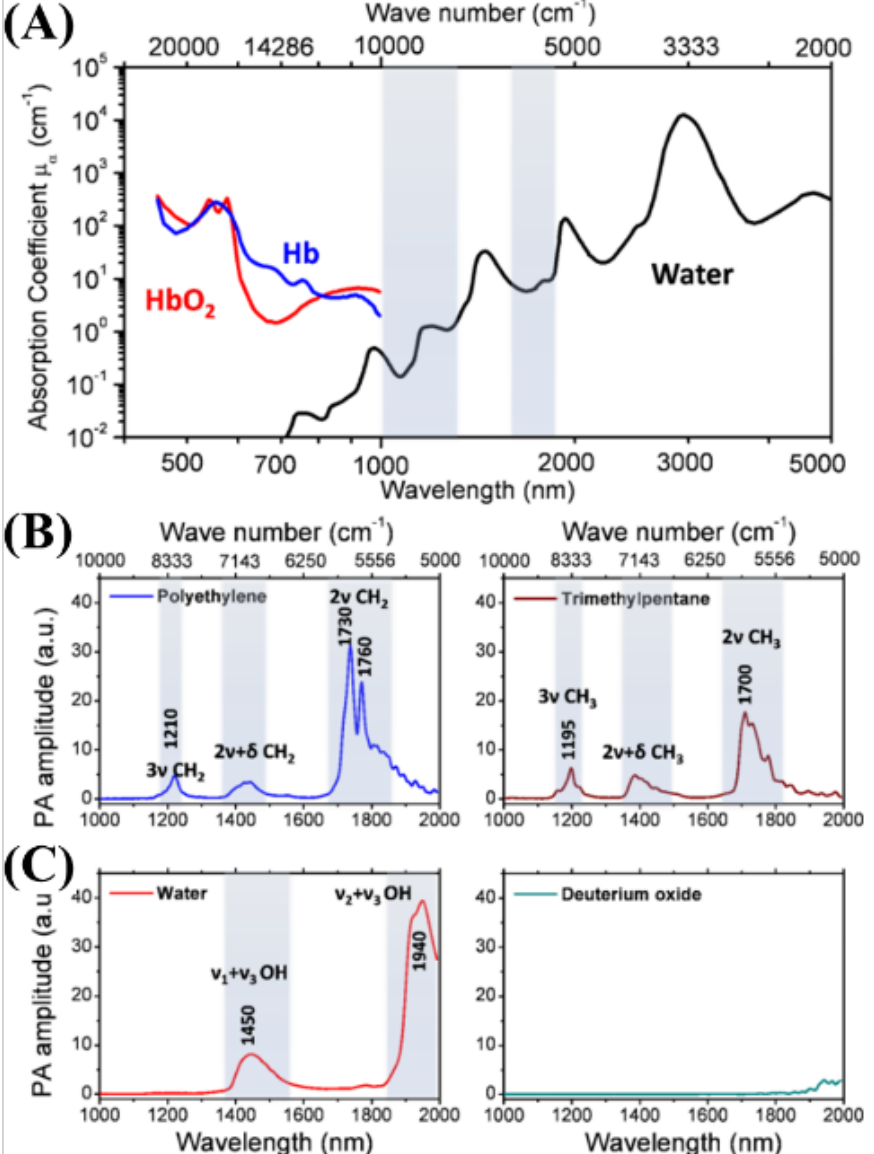
Figure 28. PA spectra of various chemical bond vibrations. ( A ) Absorption spectra of whole blood and pure water. ( B ) PA spectra of polyethylene and trimethylpentane. ( C ) PA spectra of water and deuterium oxide. Adapted from Wang et al., J. Biophotonics, 2012. Reprinted from Wang et al., J. Phys. Chem. Lett., 2013, 4, 13; 2177–2185 [46], with permission of the American Chemical